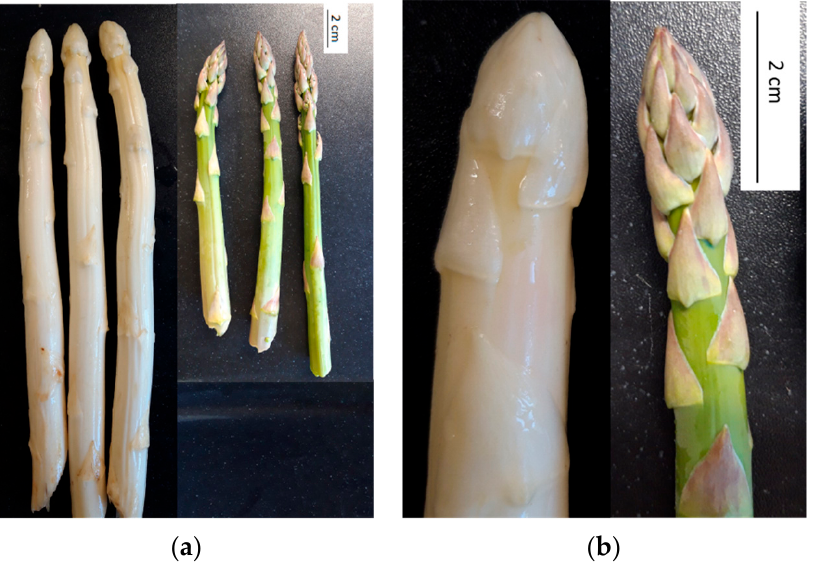
Figure 1. Clear differences in appearance are visible between white and green asparagus spears: ( a ) three freshly harvested white and green spears; ( b ) zoom in to reveal the cladodes and general tip morphology.